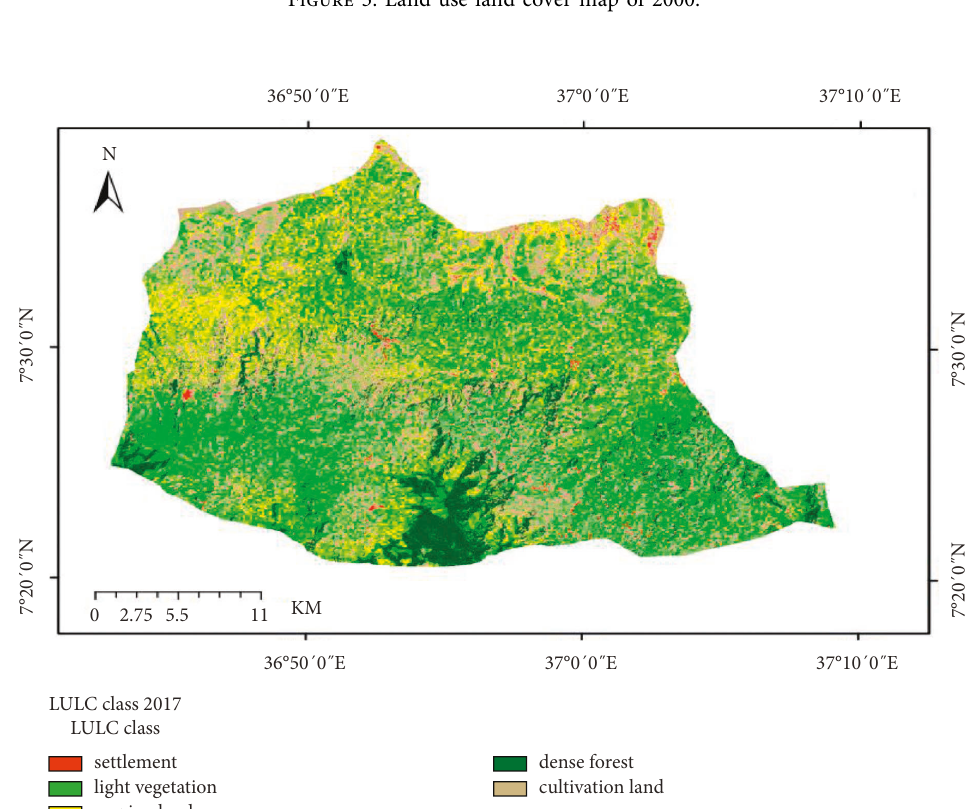
Figure 3: Land use land cover map of 2000.